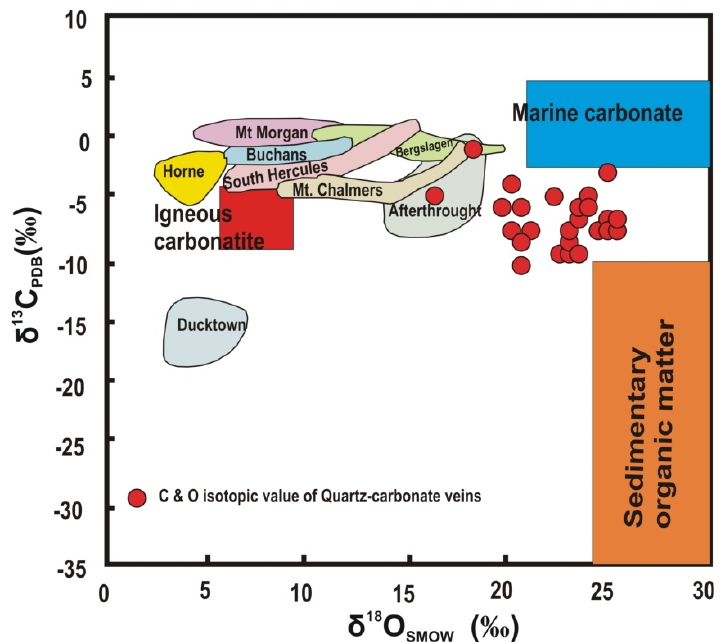
Figure 11. Carbon and oxygen isotopic values of quartz-carbonate veins from the Mundiyawas-Khera copper deposit plotted over carbonates of various VMS deposits. Data of major geologic reservoirs are from [63–66] (modified after [67,68]) and other VMS deposits from [69]. It is noted that some of the Mundiyawas-Khera quartz-carbonates overlap on Afterthought, Mt. Chalmers and Bergslagen carbonate fields. Data source as listed in Table 1. Table 1. Carbon and oxygen isotope data from mineralized carbonate vein samples from Mundiyawas- Khera copper